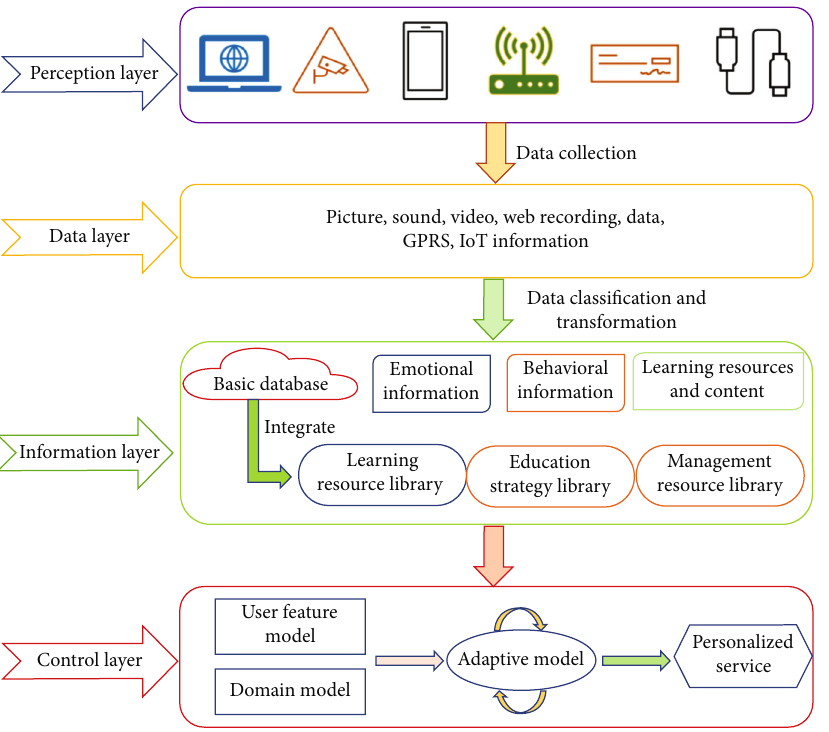
Figure 1: Education big data analysis